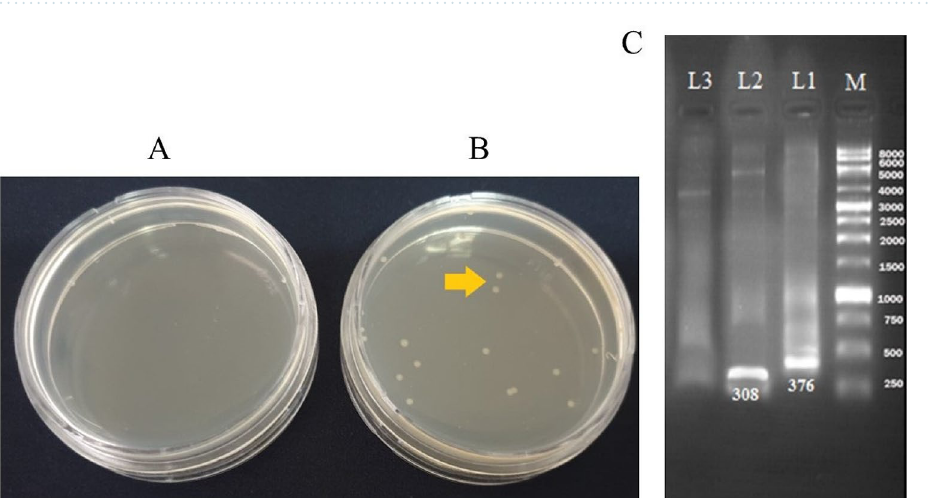
Figure 2. Schematic representation of the coding sequence of buforin I including pel B signal peptide (blue), buforin I sequence (gray), and His-Tag and stop codon (red).